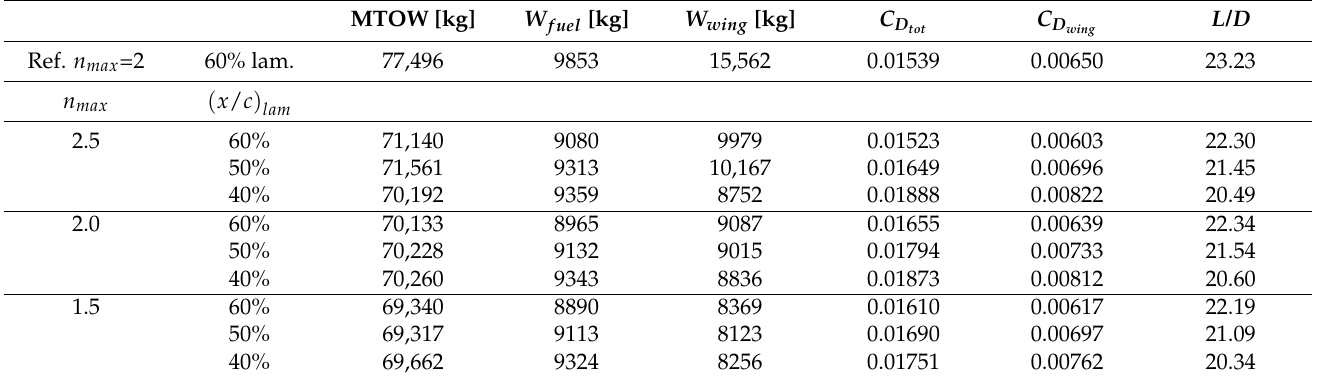
Table 7. SE 2 A midrange backward-swept wing optimisation